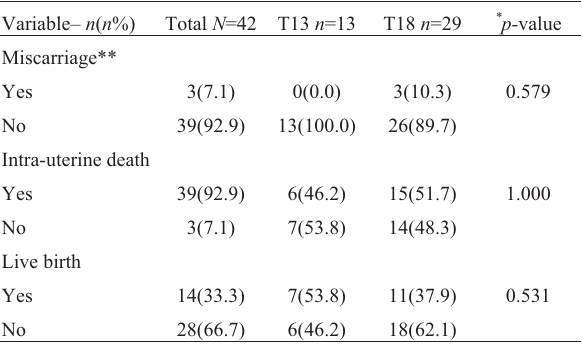
Table 4 - Natural history / outcomes for trisomy 13 and trisomy18.